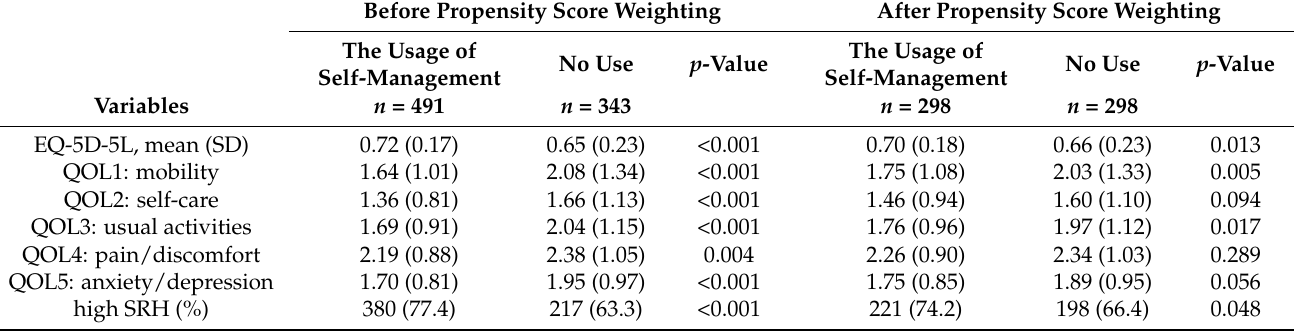
Table 2. The participants in each group and the significance level of the comparison between the two groups before and after propensity score matching. Before Propensity Score Weighting After Propensity Score Weighting The Usage of The Usage of No Use p -Value Self-Management